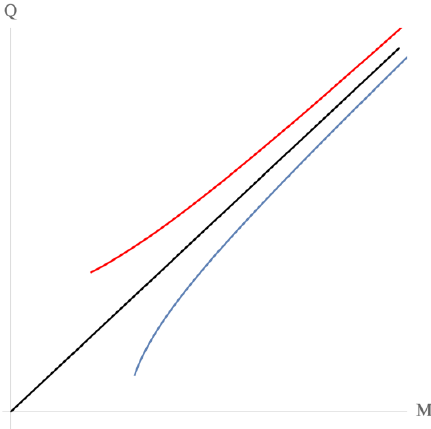
Figure 1 . Consistency with the decay of extremal black holes dictates that higher-derivative corrections should shift an extremal black hole’s charge-to-mass ratio positively (red curve). The blue curve would imply an in(cid:12)nite family of stable nonsupersymmetric